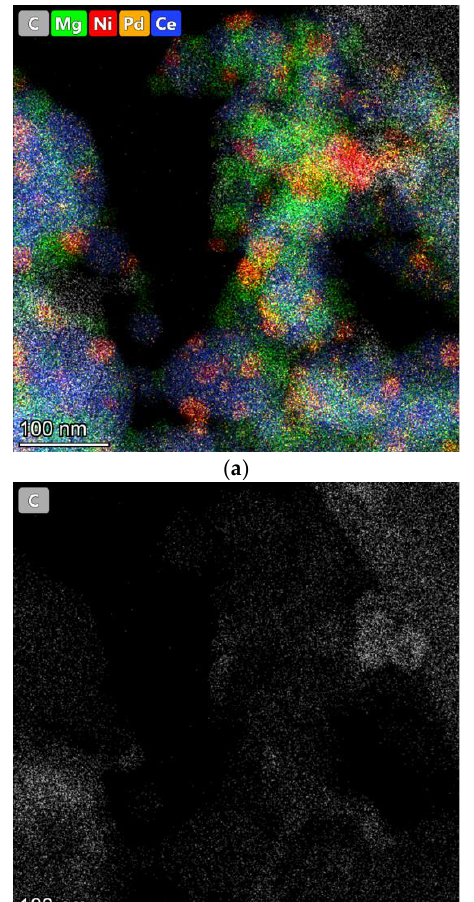
Figure 9. ( a , b ) HRTEM and ( c ) TEM images of the spent Ni-Pd/CeMg-A-S-V catalysts.